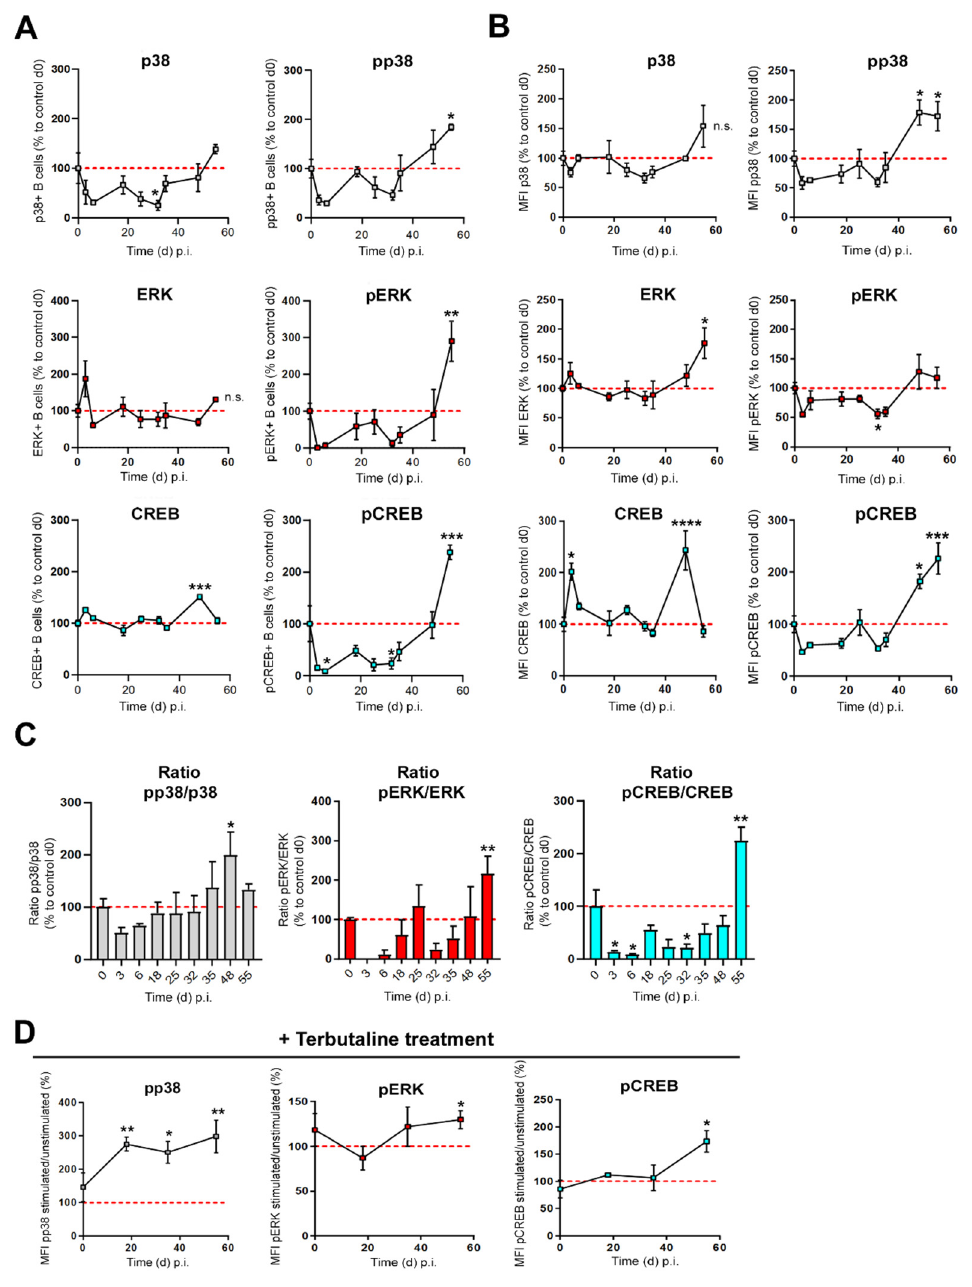
Figure 3. β 2 ‐ ADR ‐ stimulated increase of pp38, pERK and pCREB was associated with B cell ‐ derived Figure 3. β 2-ADR-stimulated increase of pp38, pERK and pCREB was associated with B cell-derived IL ‐ 10 production in established collagen ‐ induced arthritis. ( A – D ): B cells from immunized DBA/1J IL-10 production in established collagen-induced arthritis. ( A – D ) B cells from immunized DBA/1J mice were isolated from the spleen at the indicated time points and were either left unstimulated ( A – C ) or stimulated with the β 2 ‐ adrenergic receptor ( β 2 ‐ ADR) agonist terbutaline ( D ). The fre ‐ quency ( A ) and density ( B ) of the MAPK`s ERK 1/2 and p38 and of the transcription factor CREB were analyzed intracellularly by flow cytometry in their phosphorylated and non ‐ phosphorylated form ( A – C ) ( n = 3–6). The gating strategy is available in Supplementary Figure 2A–C. The ratio of pp38/p38, pERK/ERK and pCREB/CREB was determined ( C ). Furthermore pp38, pERK and pCREB was additionally investigated in B cells after terbutaline stimulation ( D) ( n = 3). The gating strategy is available in Supplementary Figure 3. The results are shown in comparison to the mean value of d0 values from non ‐ immunized mice unstimulated ( A – C ) or stimulated with terbutaline ( D ) (red reference line). Statistical significance was determined by ordinary one ‐ way analysis of variance (ANOVA) followed by Bonferroni post ‐ hoc test (( A – C ) (pCREB/CREB) and ( D )) and Student t ‐ test (pp38/p38; pERK/ERK) ( C ). Images are shown ± SEM. Frequency: p38: d0: 22.2% ± 14.4%; d32: 6.7% ± 8.1%; pp38: d0: 32.26% ± 15.7%; d55: 51.9% ± 2.52%; ERK: d0: 28.49% ± 18.96%; pERK: d0: 10.91%